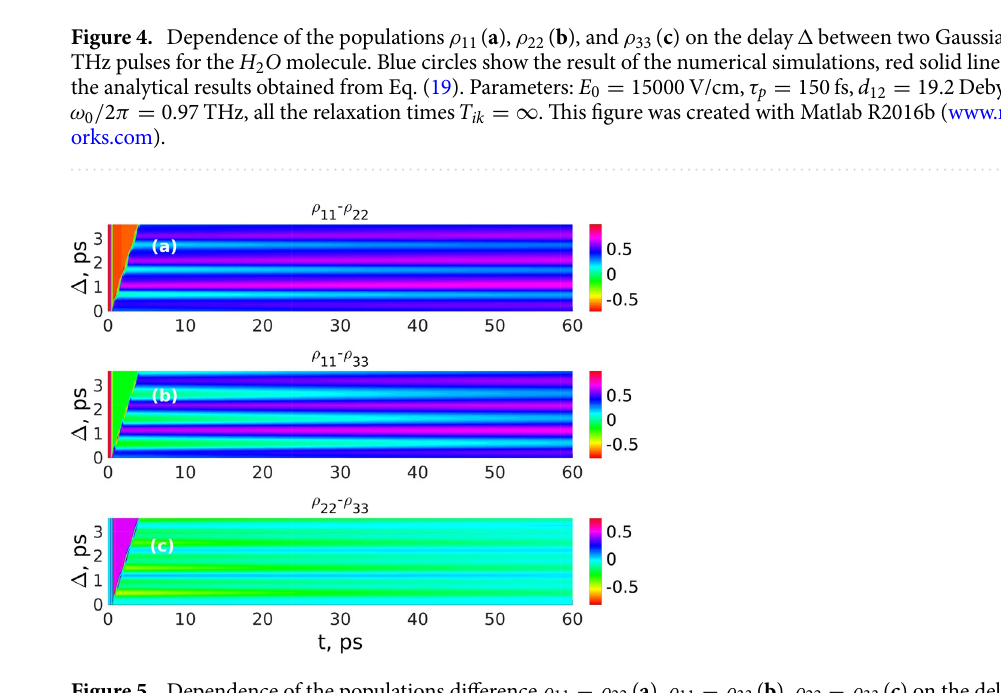
Figure 5. Dependence of the populations difference ρ 11 (cid:31) between two Gaussian THz pulses and time t for parameters of the H 2 0 molecule ( ω 0 / 2 π 19.2 Debye). Other parameters: E 0 d 12 = ps. This figure was created with Matlab R2016b (www.mathw